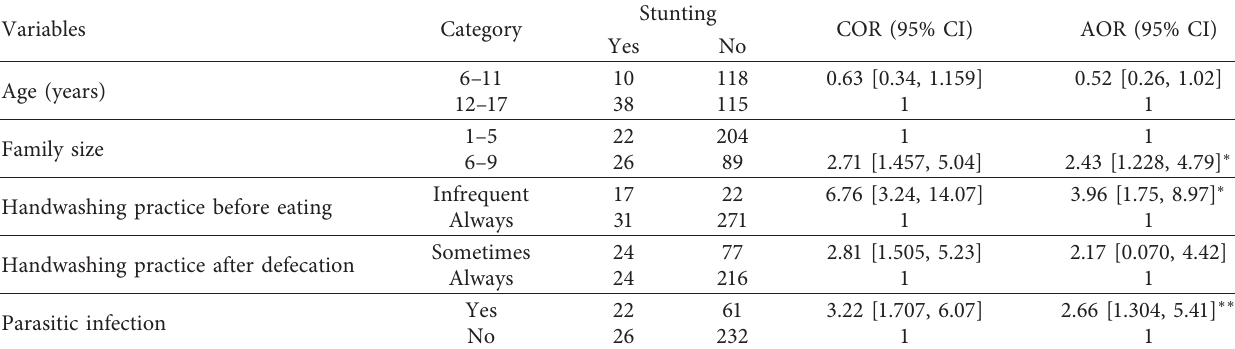
Table 5: Predictors of stunting among primary school children in Kutaber district, Northeast Ethiopia, 2019. Variables